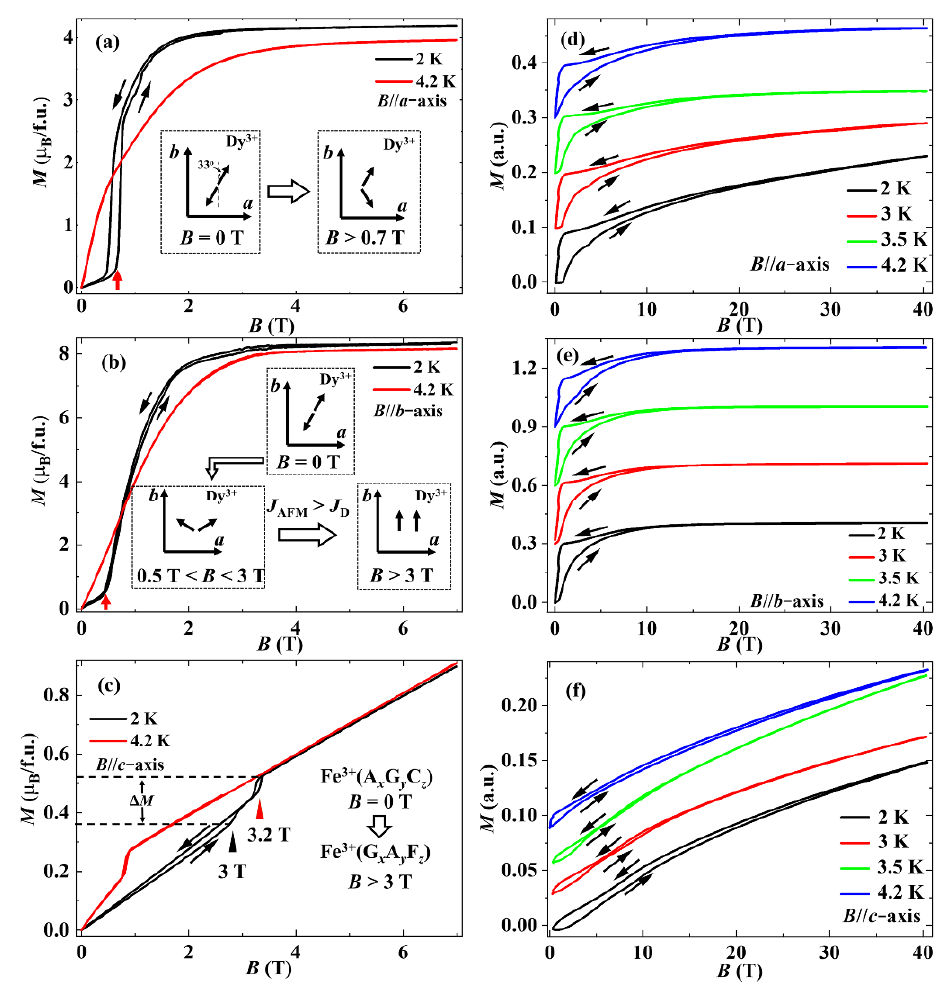
Figure 3. ( a – c ) Magnetization as a function of the static magnetic field along a -, b -, and c -axes, respectively. ( d – f ) The magnetization curves measured along the a -, b -, and c -axes under pulsed high magnetic field, respectively. The curves in the ( b , e , f ) are offset for clarity. J AFM and J D are the AFM interaction strength and anisotropy energy of the Dy 3+ -sublattice, respectively.